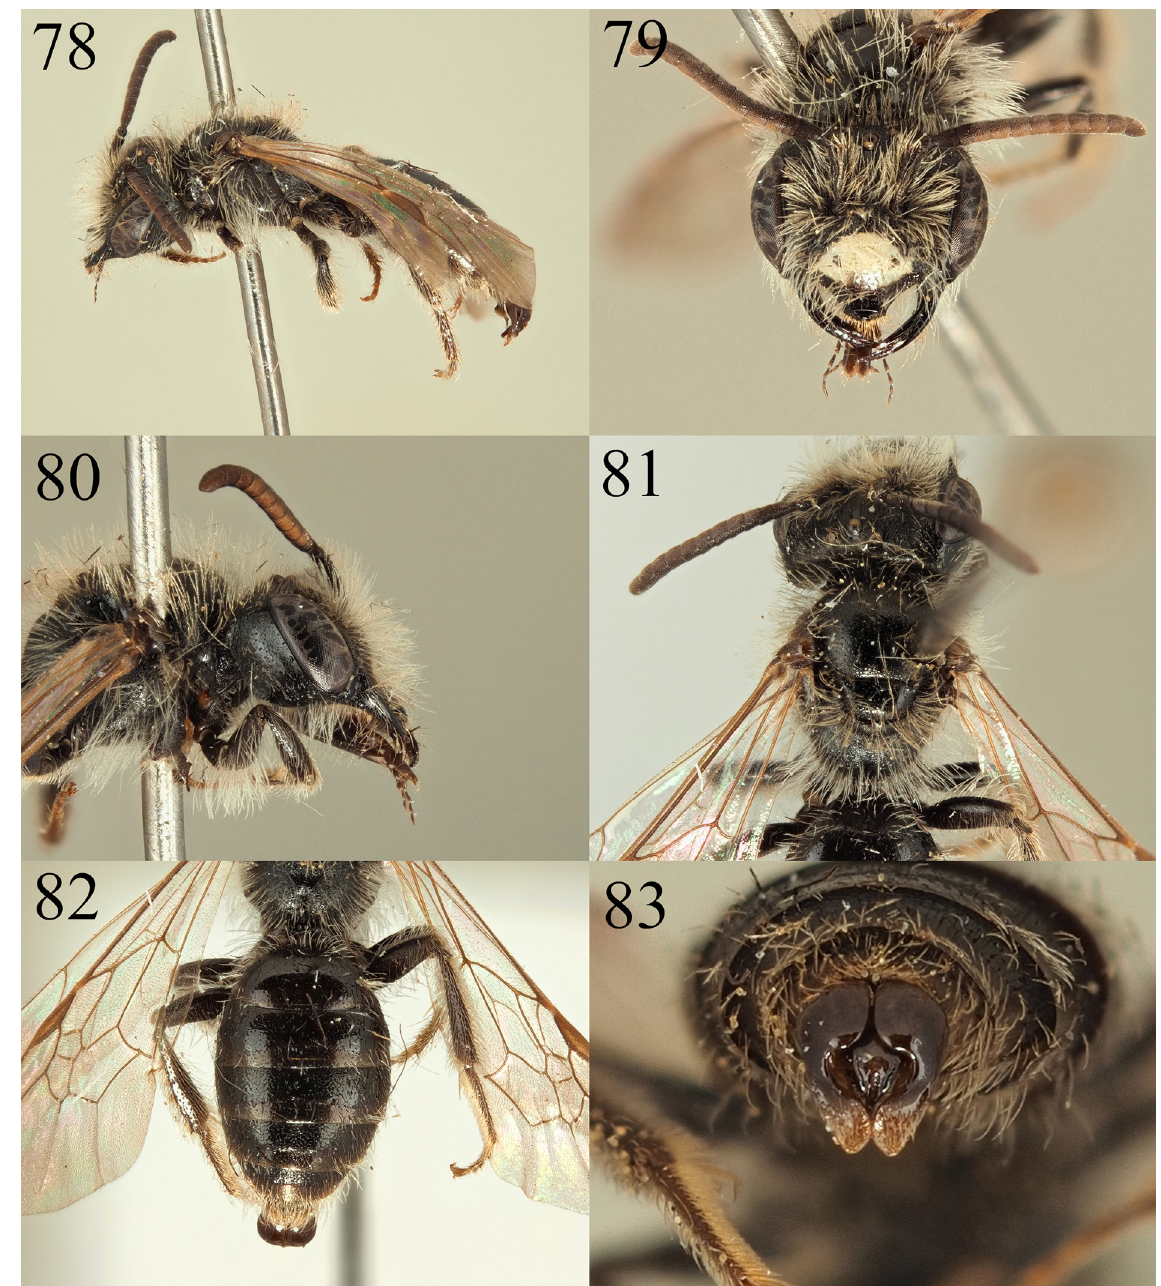
Figs 78–83. Andrena juliana Wood sp. nov. (NMNL). 78 . Male profile. 79 . Male face. 80 . Male gena. 81 . Male scutum. 82 . Male terga. 83 . Male genitalia. Not to